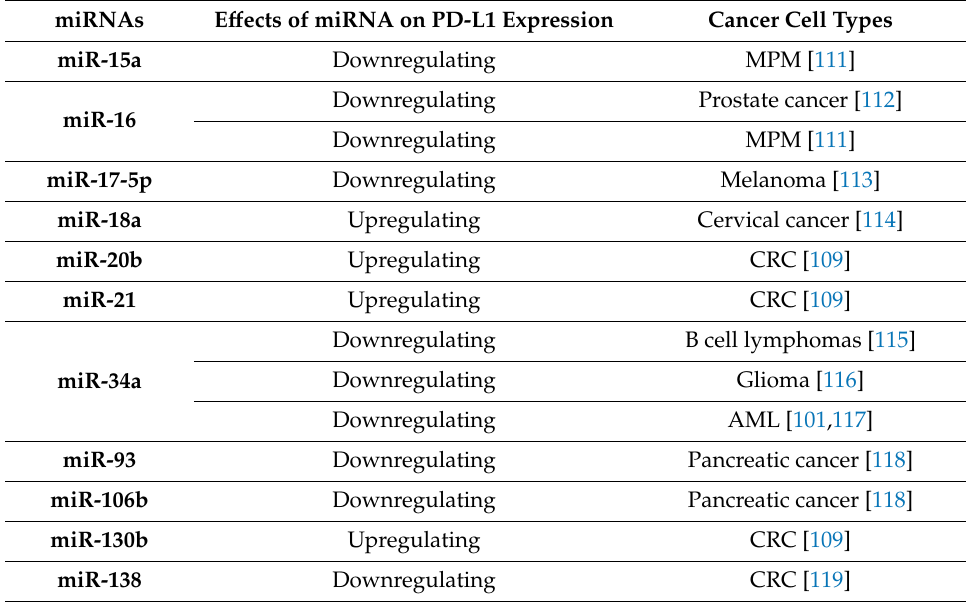
Table 2. MicroRNAs (miRNAs) regulating the PD-L1 expression on cancer cells.